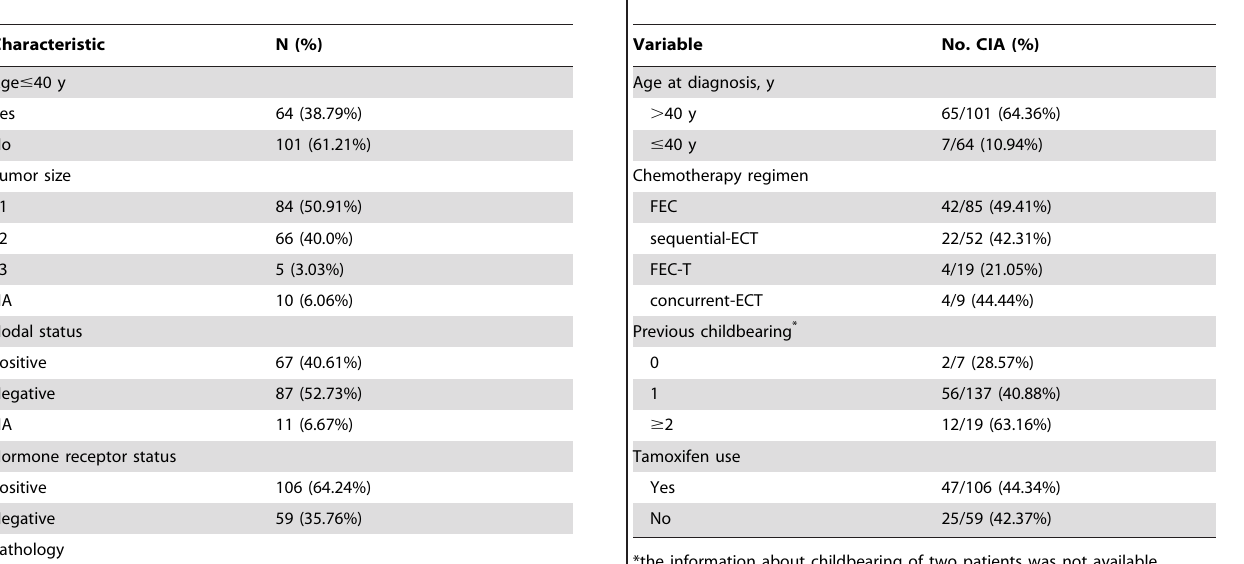
Table 1. Patients’ characteristics. Table 2. The incidence of CIA in different groups.